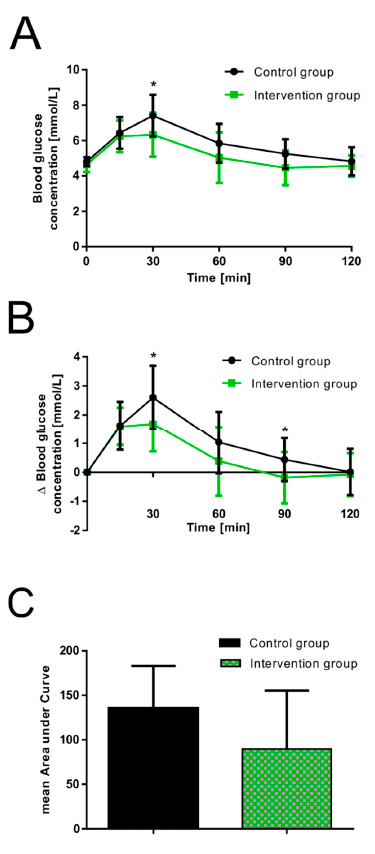
Figure 1. Effect of 2.5 mL guava fruit extract on postprandial glucose response [mmol/L] in healthy male and female volunteers. ( A ) Absolute changes in mean postprandial glucose responses over 120 min compared to control. ( B ) Relative changes in the mean postprandial glucose response over the basal fasting plasma glucose levels over 120 min compared to the control. ( C ) Calculated mean